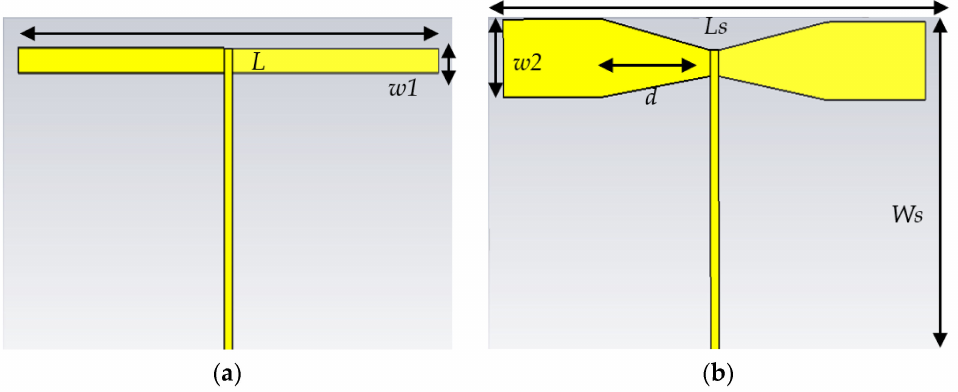
Figure 2. Two dipoles are modeled in CST Microwave Studio: ( a ) conventional dipole; ( b ) biconical